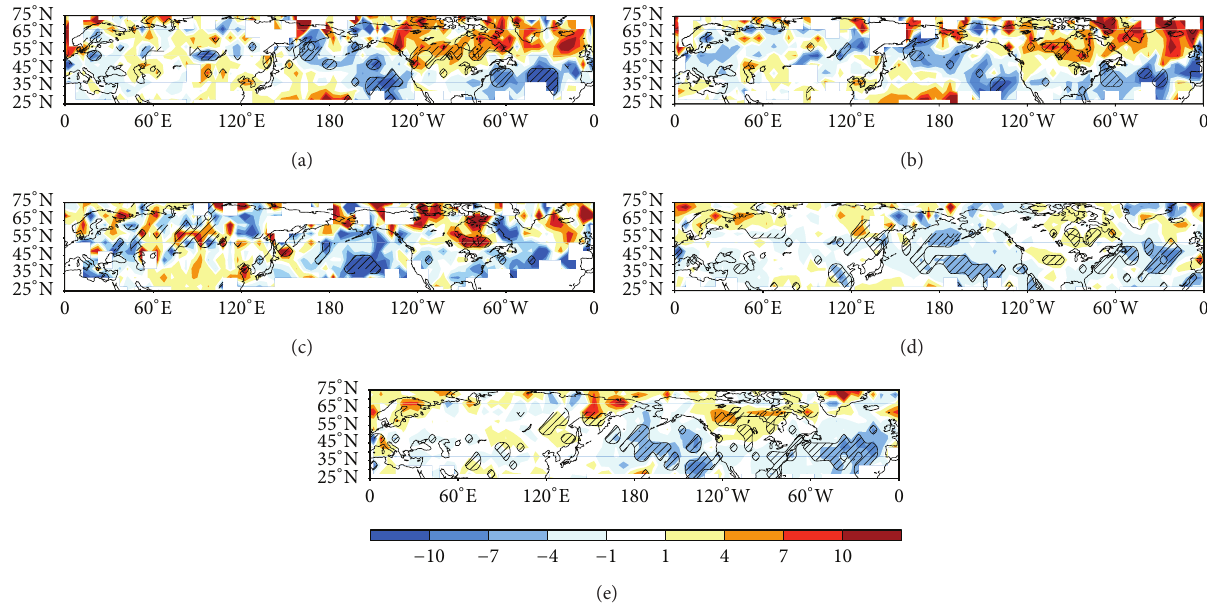
Figure 9: NH storm track intensity composite (hPa) in JFM for (a) El Ni˜no relative to La Ni˜na (shaded) 95% significance (hatched) for (a) NCEP1, (b) like (a) but for ERA40, (c) like (a) but for CFSR, (d) like (a) but for CMIP1, and (e) like (a) but for